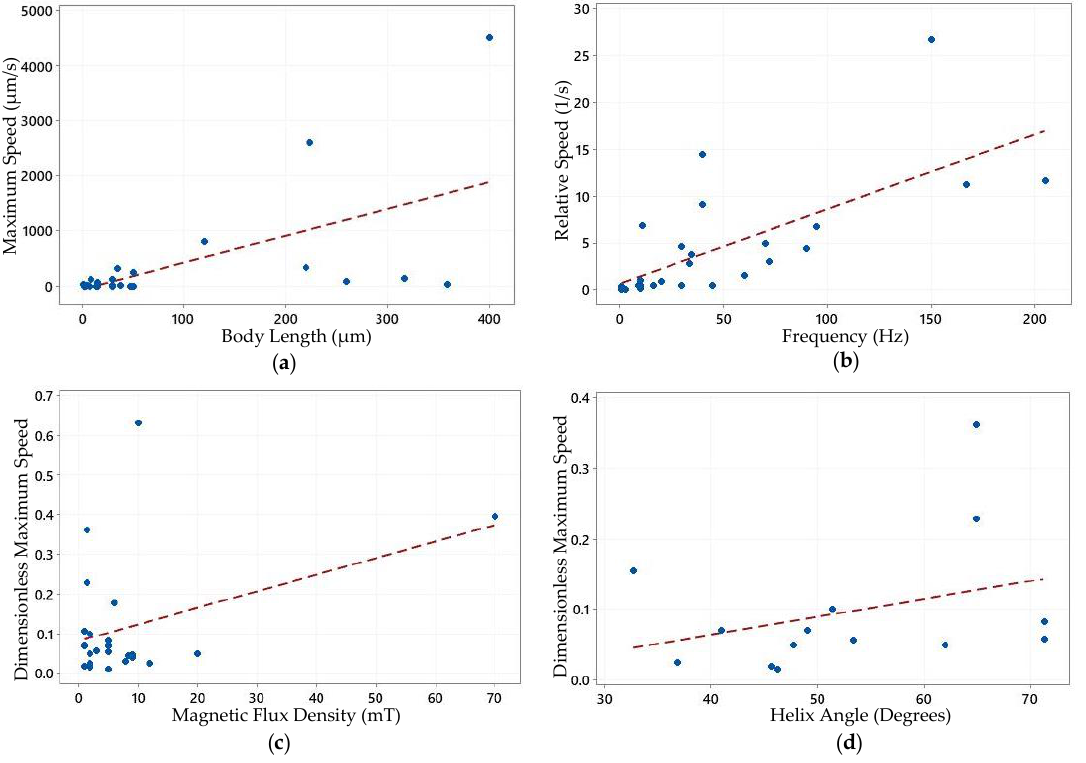
Figure 9. Performance analysis of microrobots: ( a ) Variation of maximum speed against body length; ( b ) variation of relative speed against frequency; ( c ) variation of dimensionless maximum speed against magnetic flux density; ( d ) variation of the dimensionless maximum speed of helical microrobots against helical angle. (Blue color dots represents the data points and red color dotted line represents the regression line.)